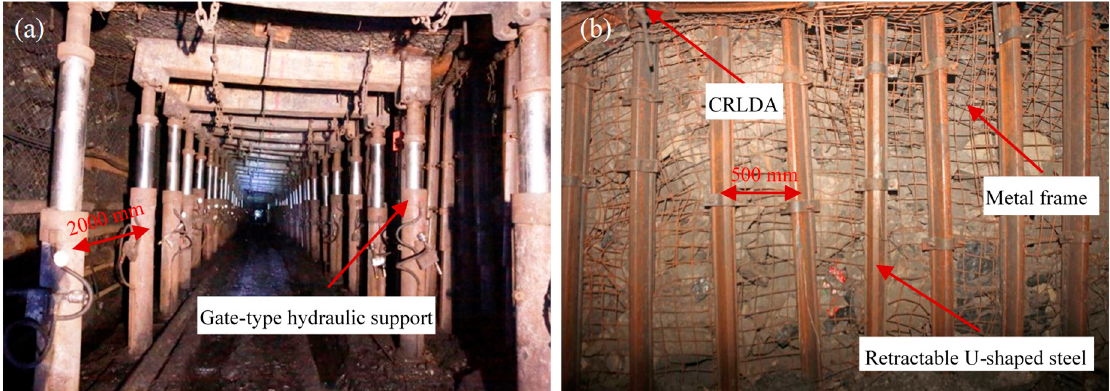
Figure 12. Design of the surrounding rock control in GERRC. ( a ) roof temporary support; ( b ) gangue prevention support.